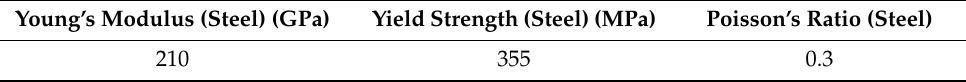
Figure 4. The p–y curve for the soil between − 8 m and − 14 m. Table 3. Steel material properties used in the FE